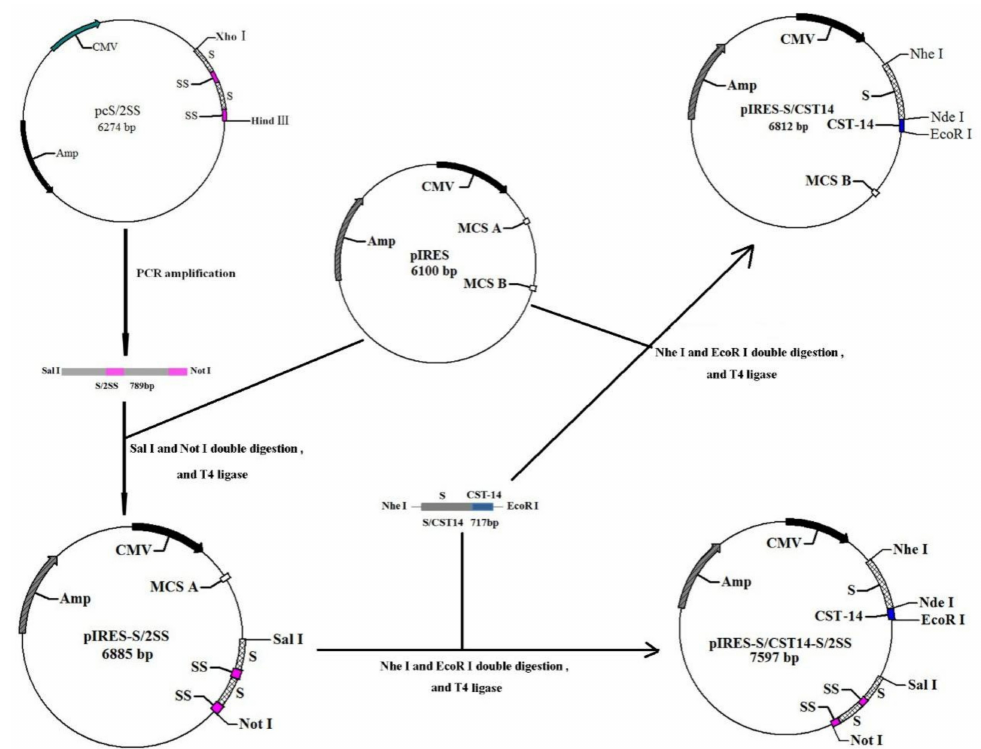
Figure 1. Schematic diagram for the construction of plasmid pIRES-S/CST14 -S/2SS. The S/2SS gene encoding two copies of somatostatin genes presented by the hepatitis B surface antigen (HBsAg) particle was amplified by PCR with Sal I and Not I. After purification, the target gene was inserted into the pIRES vector. Corstitatin-14 was chemically synthesized and fused with the hepatitis B surface antigen (HBsAg) genes, which formed the S/CST14 fragment with the Nhe I and EcoR I sites. The S/CST14 fragment was then inserted into pIRES-S/2SS plasmid to construct the dual expression plasmid